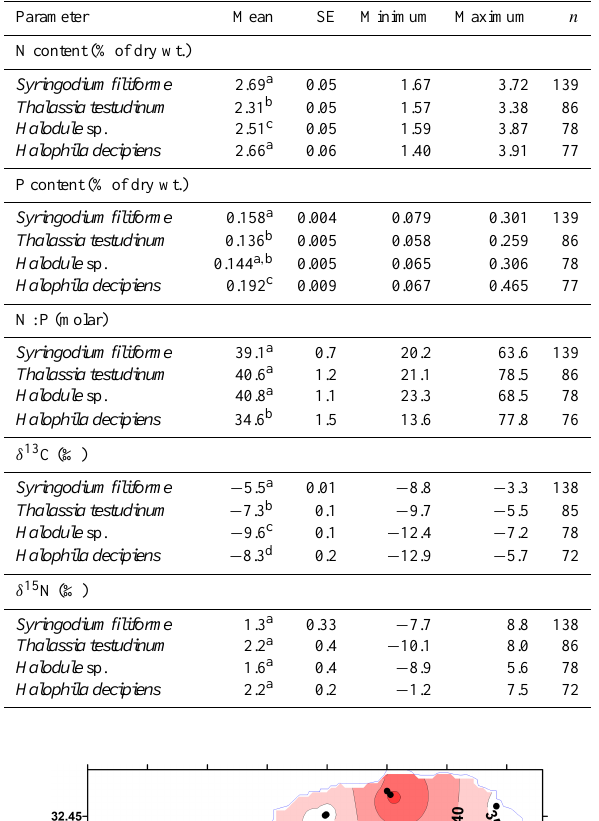
Table 2. Nitrogen and phosphorus content, N:P, δ 13 C and δ 15 N values of seagrass leaves from the Bermuda Platform. Superscripts indicate homogenous groups as indicated by Student–Newman– Keuls post hoc tests in ANOVA of data grouped by species; sig- nificant differences at α = 0.05.